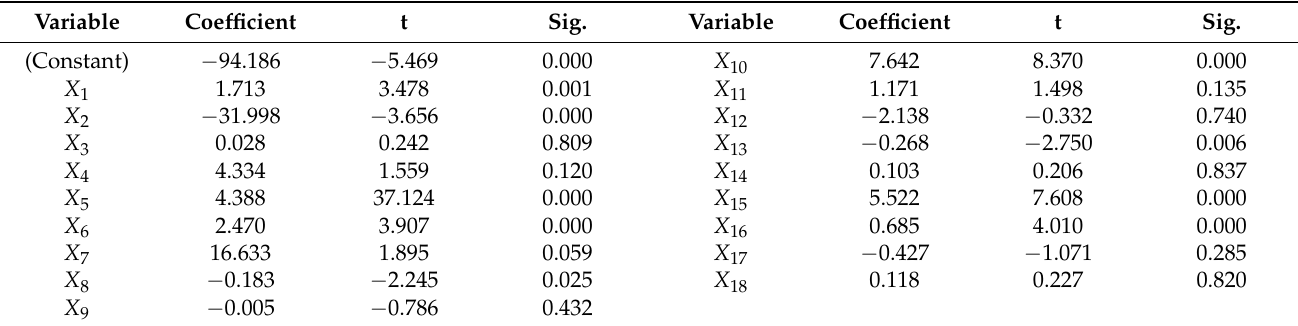
Table 10. Coefficient and significance of general linear